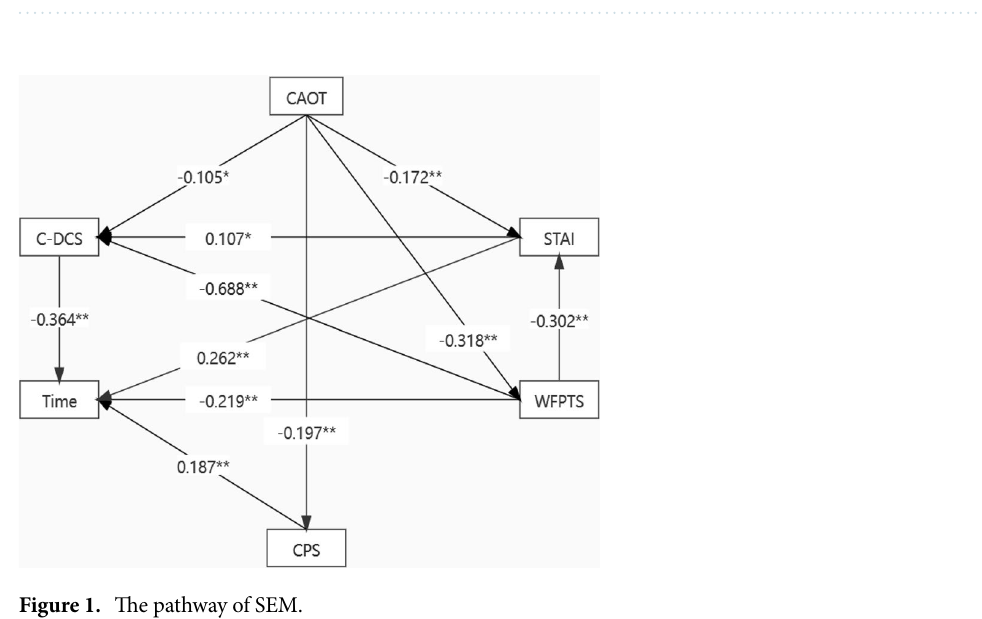
Figure 1. The pathway of SEM.